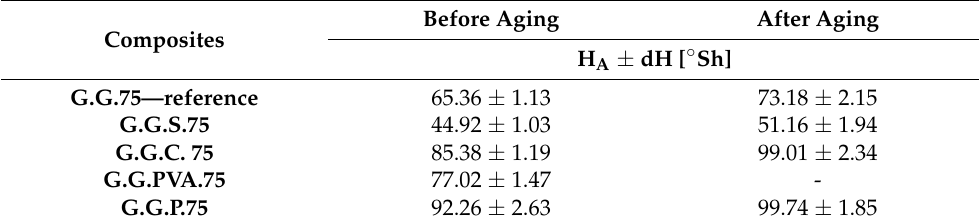
Table 10. Shore A hardness measurement results with standard